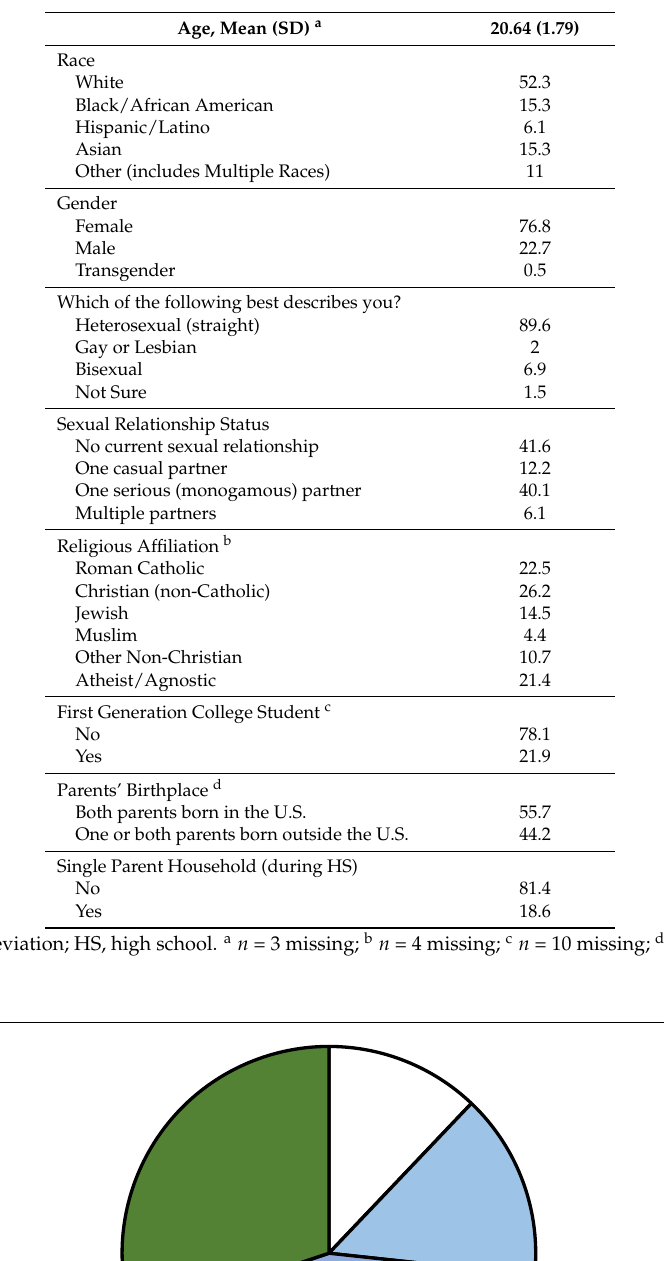
Table 1. Characteristics (%) of Analytic Sample ( n = 608).